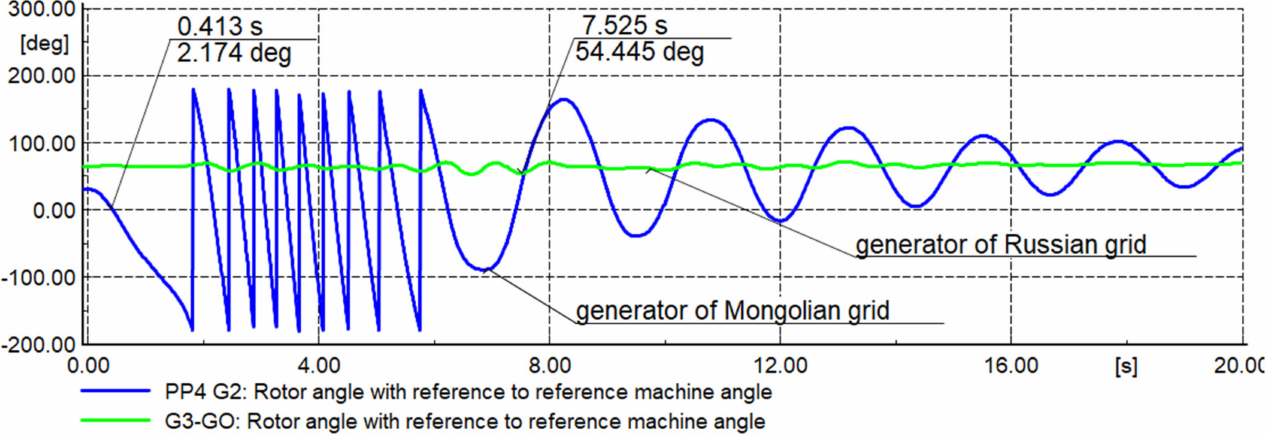
Figure 24. Results of the rotor angle considering existing OOS protection action at Line